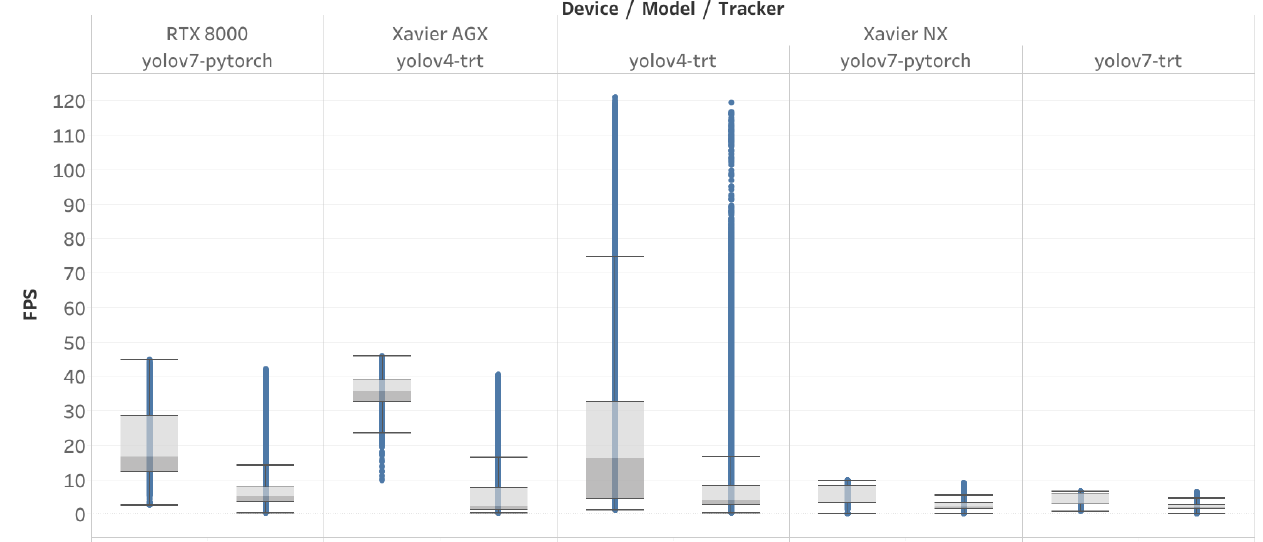
Figure 9. Inference speed per device, detection model, and use of tracker. To analyze the influence of each component of the AI system and control for variability due to different devices and video resolutions, we generated a set of scatter plots to measure the inference speed on the Jetson Xavier NX device with an input video resolution of 1920 × 1080. Figure 10 illustrates the scatter plot of the inference speed per number of detected objects in each frame using both PyTorch and TRT versions of the YOLOv7 object detection model. As previously noted (about Figure 7), the PyTorch implementation achieved higher inference speeds compared to the TRT implementation. Figure 10 appears as a superimposition of three plots, which we will distinguish in subsequent figures.